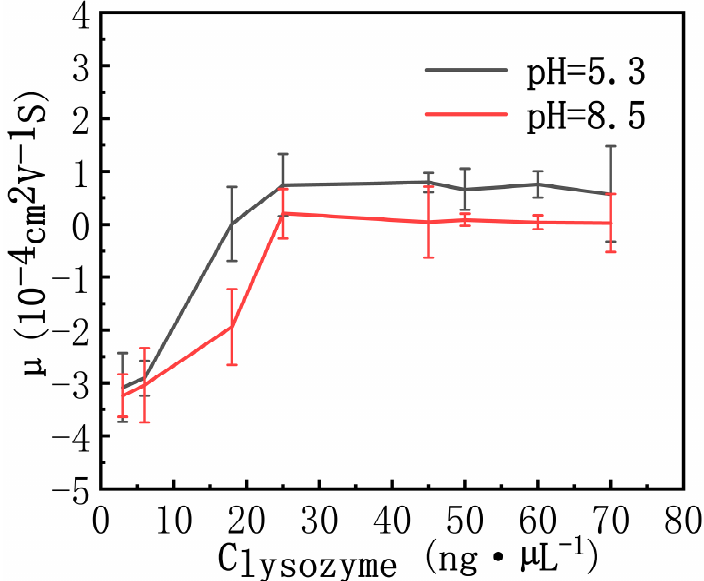
Figure 5. The electrophoretic mobility of DNA measured as a function of lysozyme concentration in a solution of pH = 5.3 and pH = 8.5. The error bars represent the corrected sample standard de- viation.